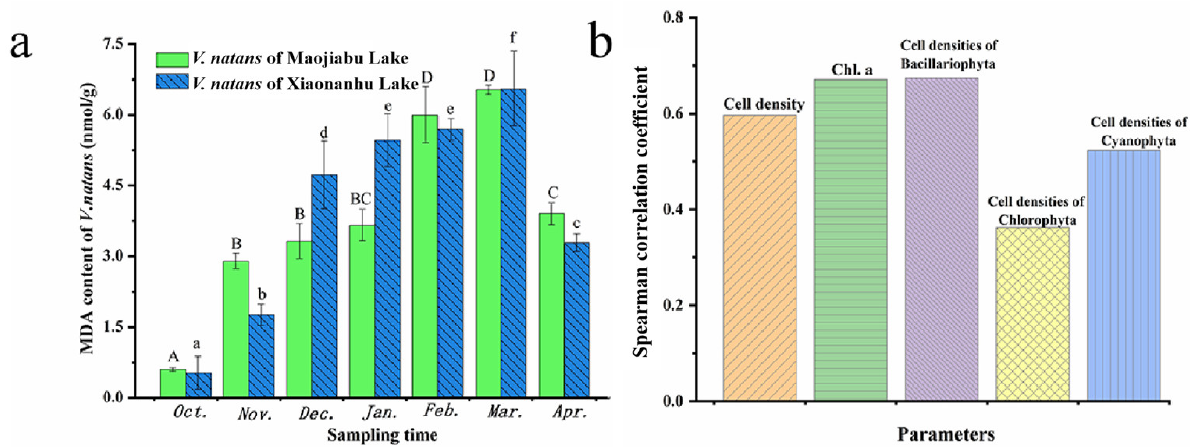
Figure 7. Malondialdehyde (MDA) contents of V. natans and correlations with periphytic-algae bi- omass: ( a ) Changes in the MDA content (mean ± standard deviation (SD)) in Maojiabu Lake and Xiaonanhu Lake; ( b ) Spearman’s correlation coefficient between the MDA content and cell density, Chl. a content, Bacillariophyta cell density, Chlorophyta cell density, and Cyanobacteria cell density. The significant differences are assigned different superscript letters in Maojiabu Lake (A–D) and Xiaonanhu Lake (a–f) ( p < 0.05). Error bars show the standard deviation (n = 3).